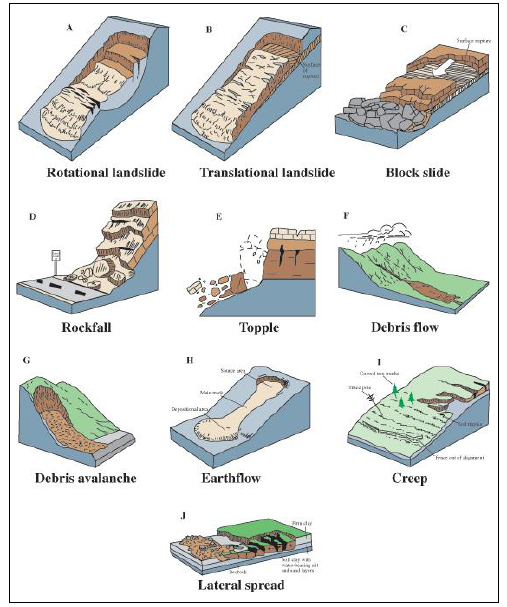
Figure 1. The Major Types of Landslide Movement (Source: Highland,